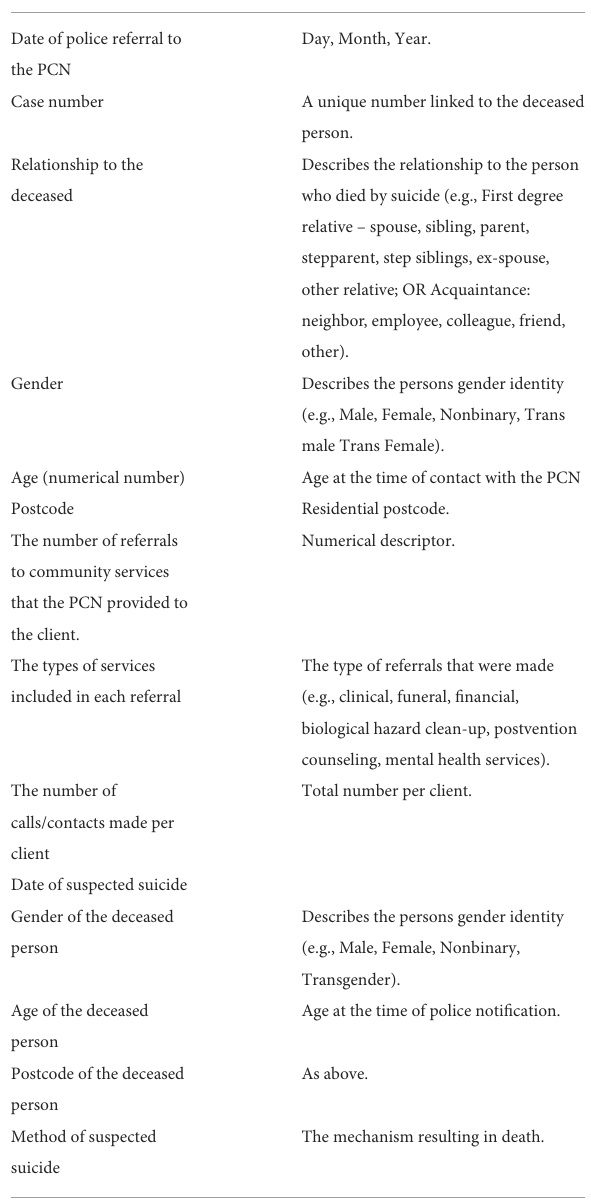
TABLE 1 Variables included in the quantitative